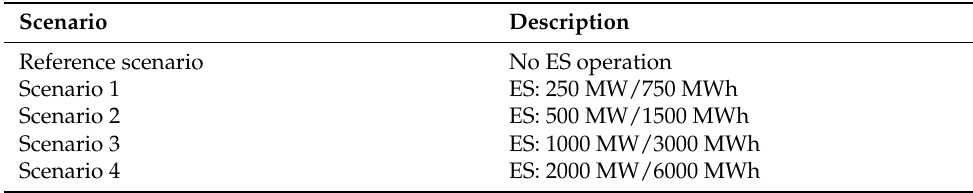
Table 3. Description of the main simulation scenarios, where ES—energy